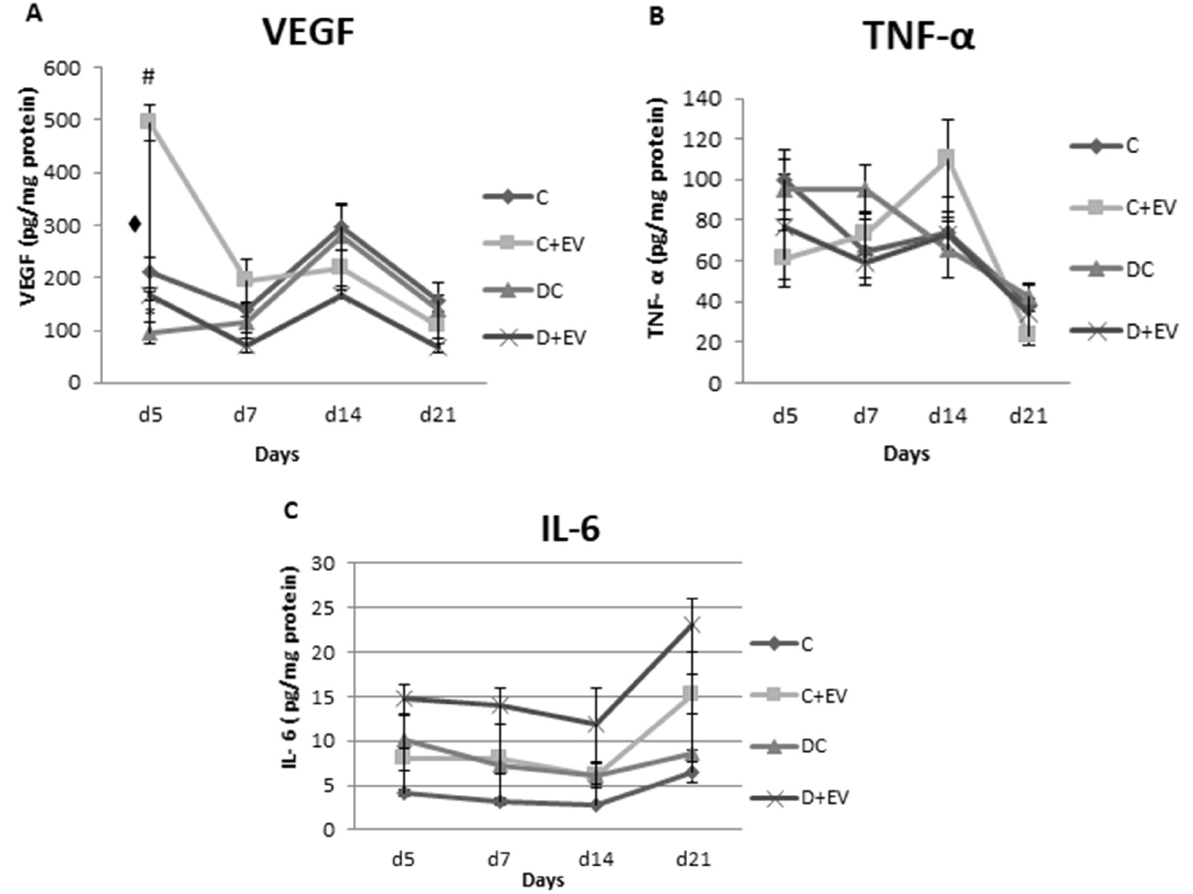
Figure 3. a. Distribution of VEGF levels by groups and days. #: Indicates that there is a statistically significant difference between the C+EV and D+EV groups. *: Indicates that there is a statistically significant difference between the DC group and all the other groups (C, C+EV, D+ EV). : Indicates that there is a statistically significant difference between the C and C+EV groups. b. Distribution of TNF-α levels by groups and days. c. Distribution of IL-6 ♦ levels by groups and